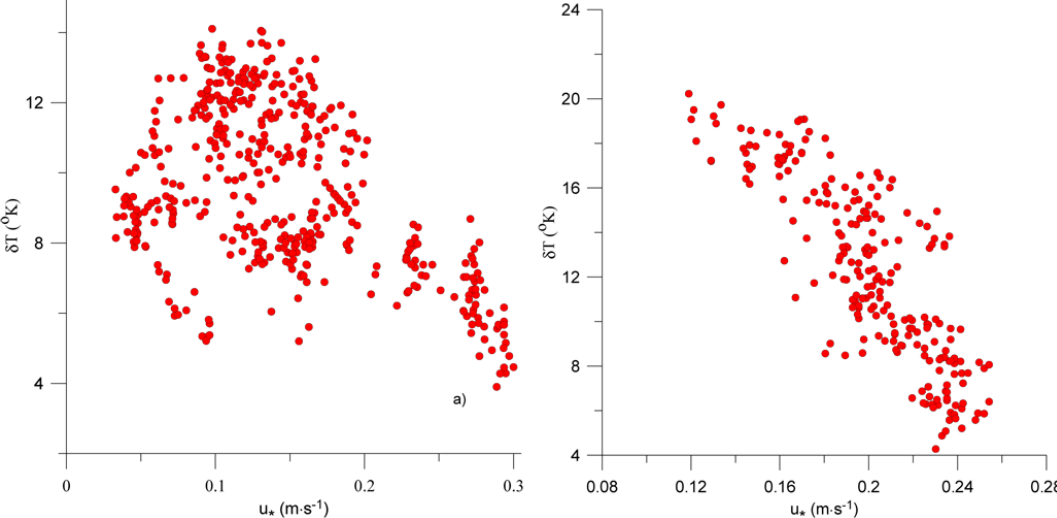
Fig. 8. Temperature drop δT as a function of u ∗ (a) for 28 July 2007, (b) for 27 July a.m. 2009.